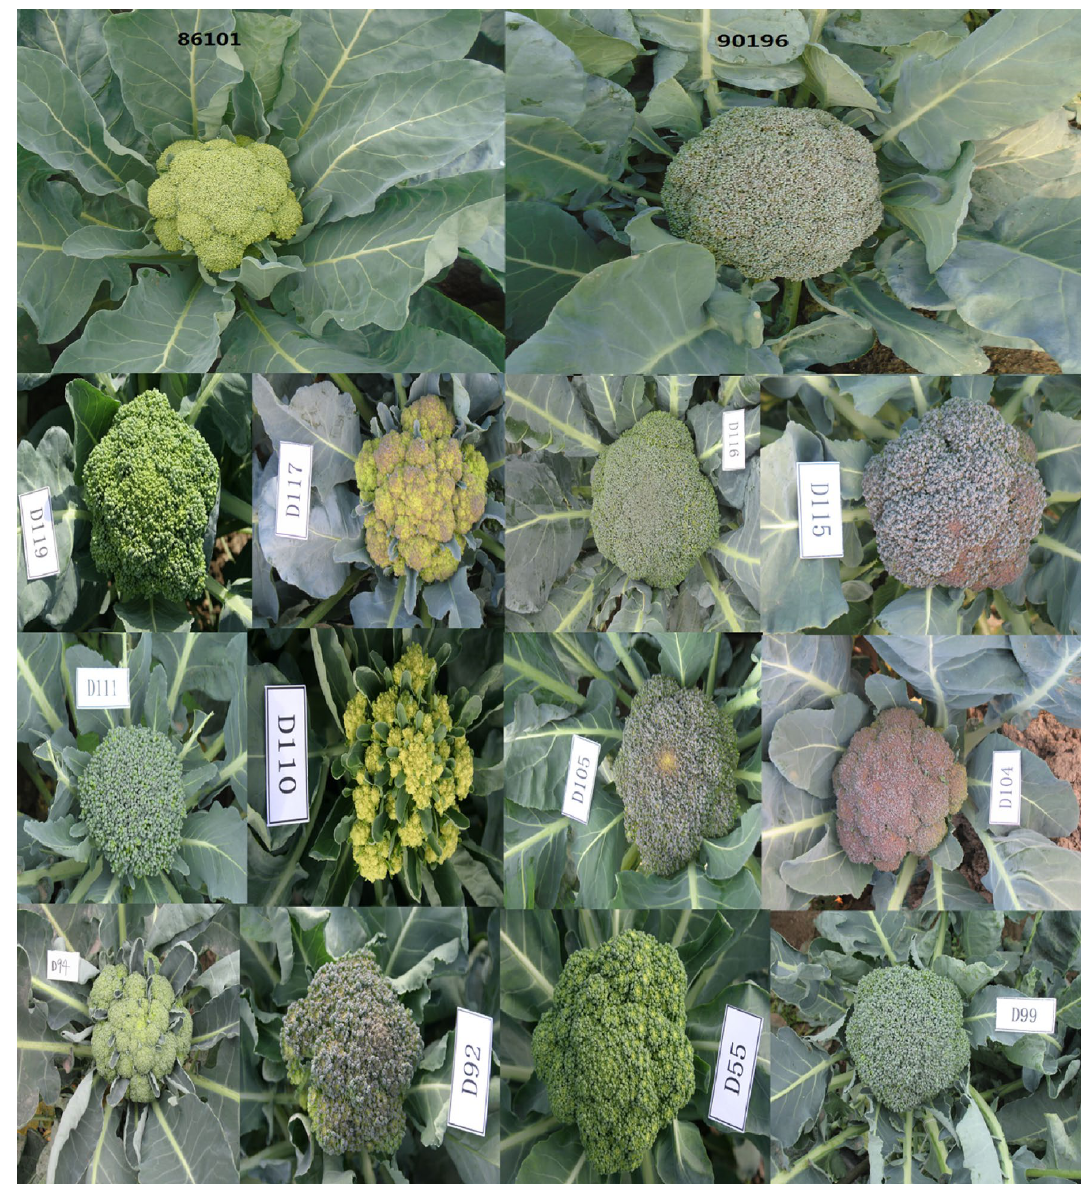
Figure 5. Phenotypic traits of the parental lines 86,101 and 90,196 and some individual DH